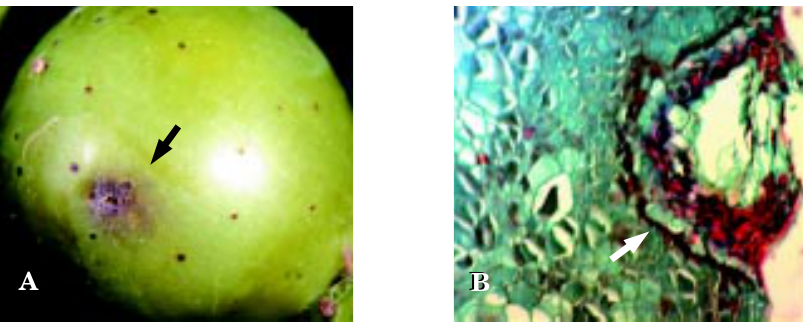
1. A. Lesion (arrow) produced on grape cv. Chardonnay 10 days after pricking and inoculation with Pm. aleophilum P99.4, 10 (cid:1) . B. Paraffin section of the wound area showing pronounced periderm formation (arrow) (400 (cid:1)